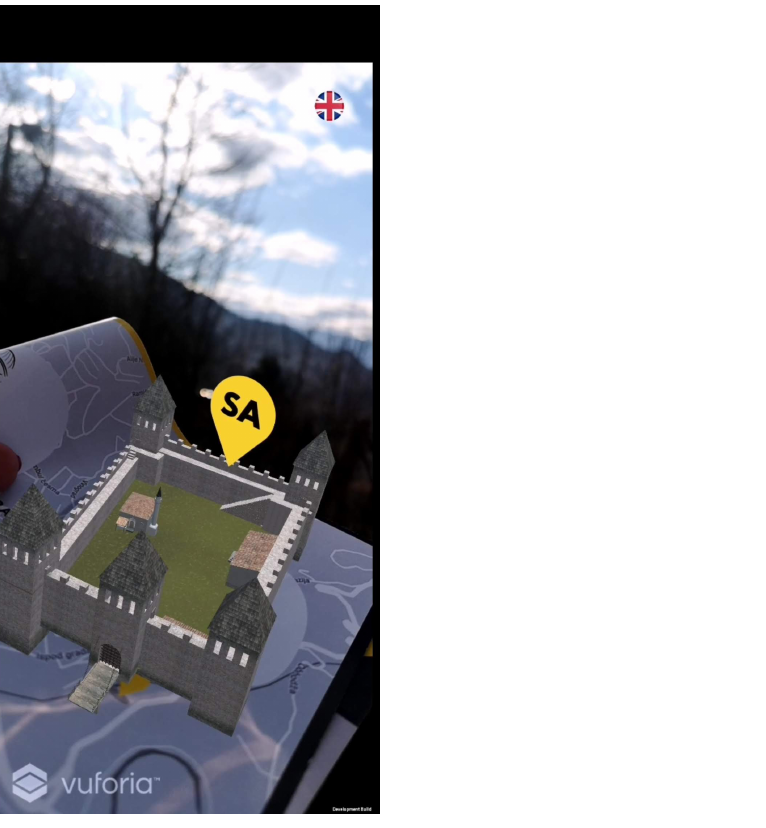
Figure 5. Clickable pin to show additional information about an object on the Sarajevo 5D Tour